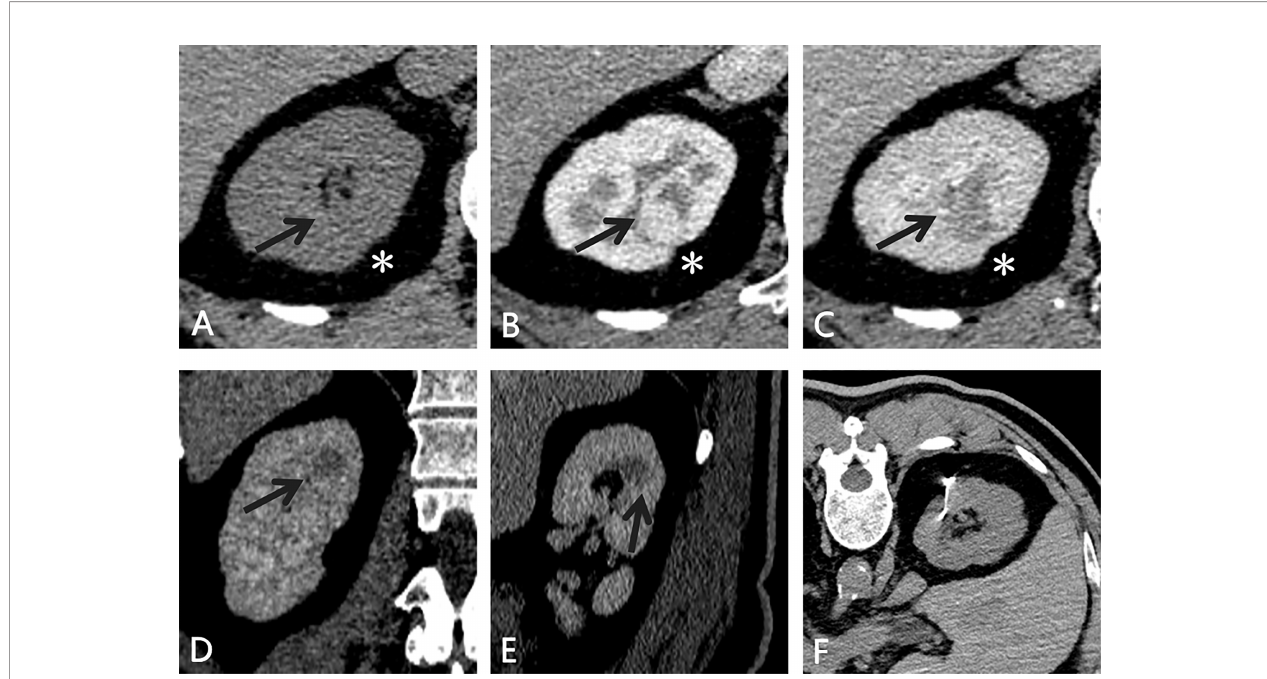
FIGURE 1 | CT of the small, totally endophytic renal mass. (A – C) An enhancing endophytic mass(black arrow) measuring 1.6×1.4 cm was observed in the middle part of the right kidney. Slight shrinkage (*) was noted and taken as a puncture reference. During the excretory phase, the mass (black arrow) showed a different enhancementpattern(contrastwashout)oncoronal (D) andsagittal (E) views. (F) After themicrocoilwasimplantedtargetingthelesion,abdominalCTwasperformedtocon fi rm